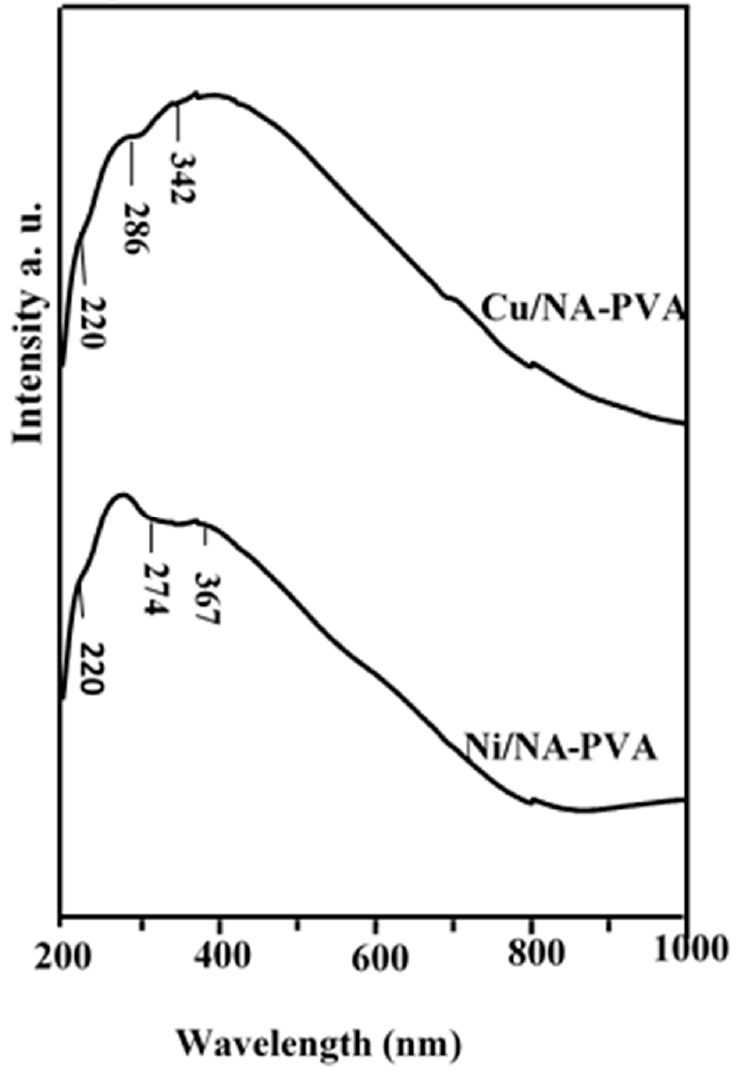
Figure 3. Diffuse reflectance versus wavelength for Ni/PVA-NA and Cu/PVA-NA samples. Spectra of Ni/NA-PVA complex demonstrated broad band 367 nm is related to the 3 A → 3 T 2g (F) 2g with charge transfer transitions, respectively. Thus, the Ni/NA-PVA complex has square planar geometry [24]. On the other hand, Cu II/ Cp complex shows a relatively broad band at 342 nm with a low intensity. This band could be ascribed to ( 2 E g → 2 T 2 g ) M → L charge transfer transitions, which is consistent with square planar geometry